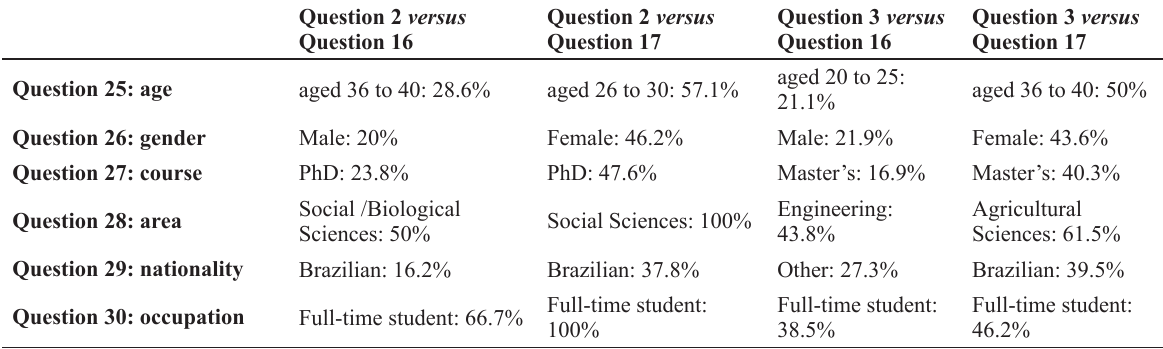
Larger percentage verified among respondents who marked “I fully agree or disagree” (Question 2 and Question 3) X “yes” (Question 16 and Question 17) crossed with the responses to the questions with profile